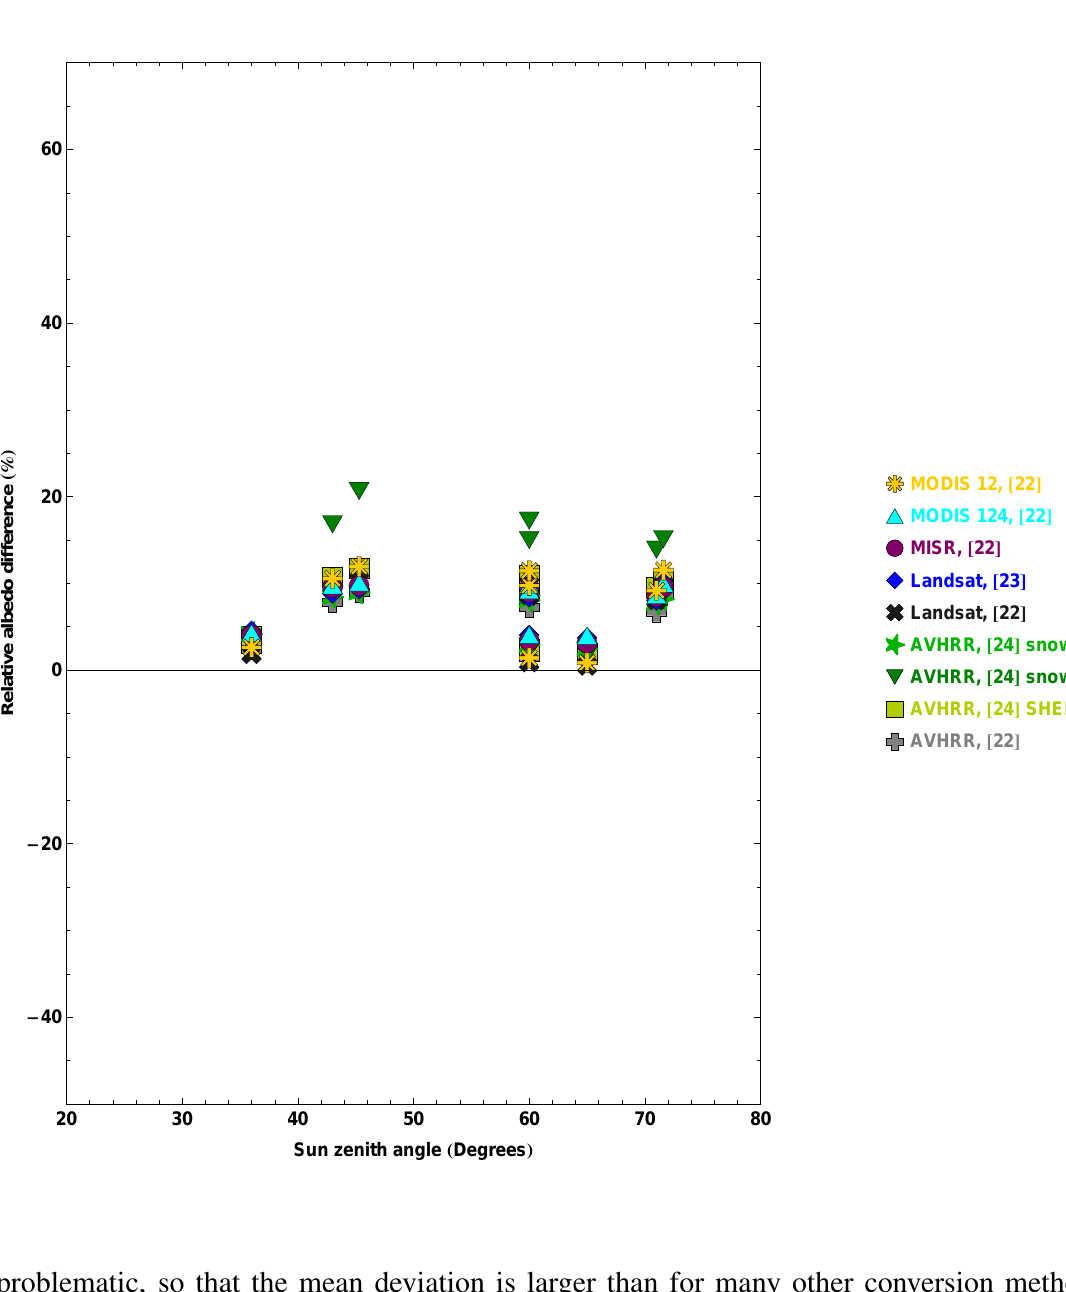
Figure 10. The relative difference between two broadband albedo estimates and the sun zenith angle for snow. We derived the two albedo values were derived as follows: (1) by using various dedicated snow broadband conversion formulae from Greuell and Oerlemans, Knap and Oerlemans and Xiong et al. [22–24] and (2) by directly integrating the measured BRF